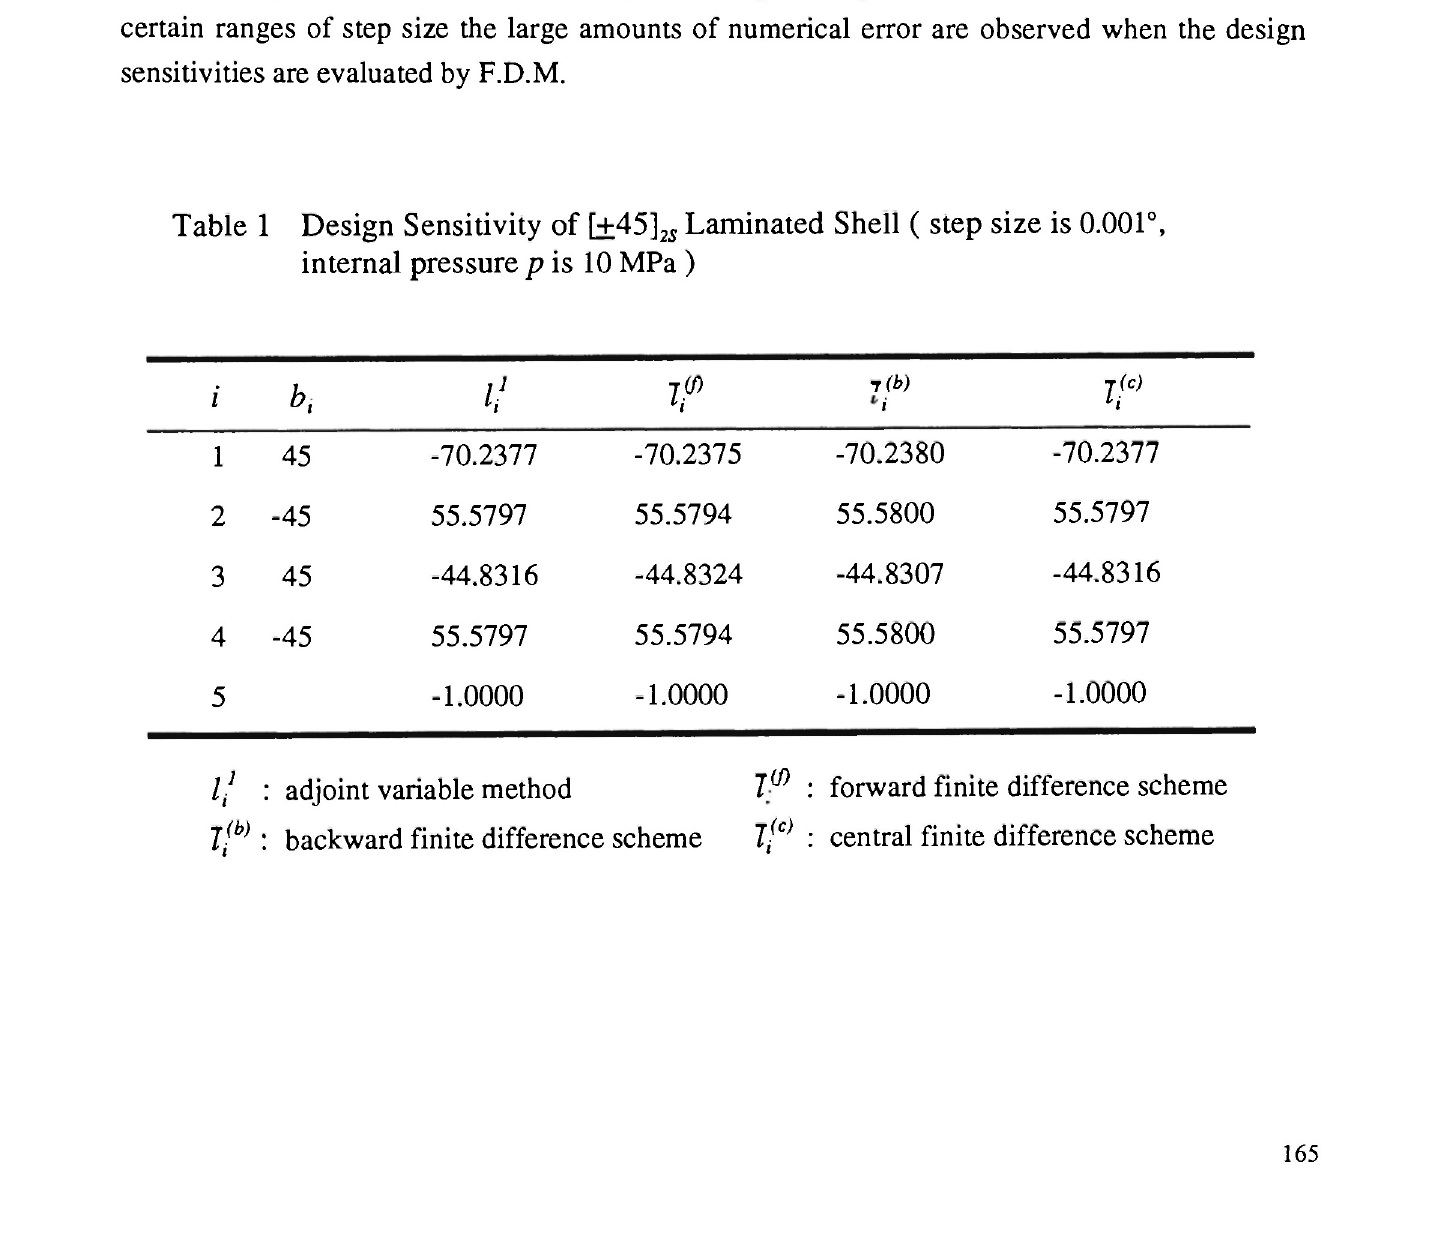
Design Sensitivity of [±45]